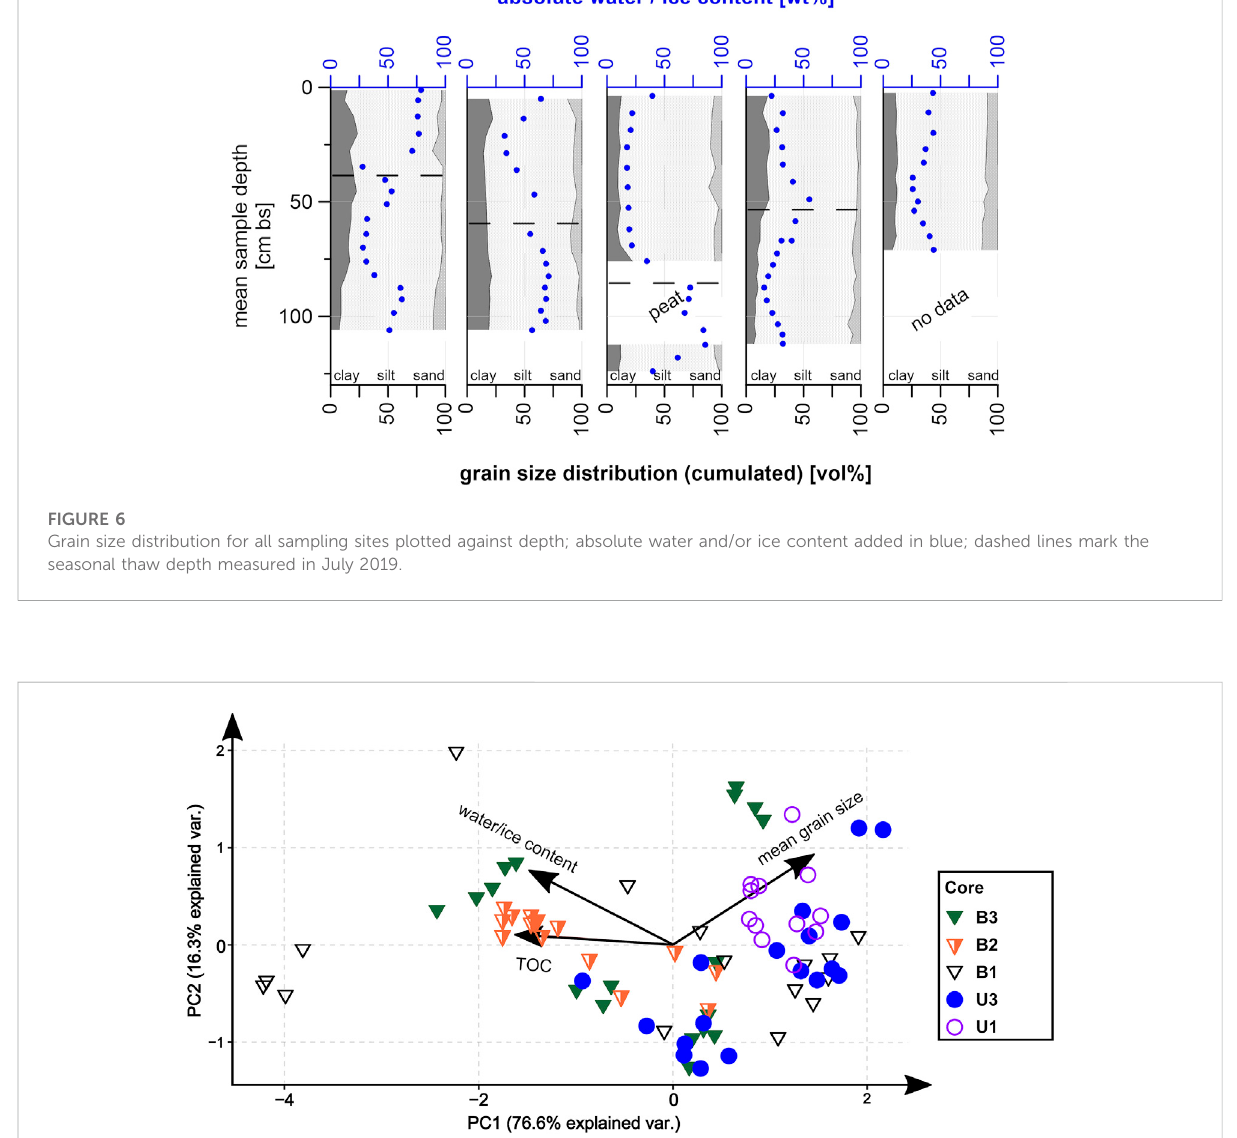
FIGURE 7 Results of the principal component analysis (PCA) for variables total organic carbon (TOC), water/ice content, and mean grain